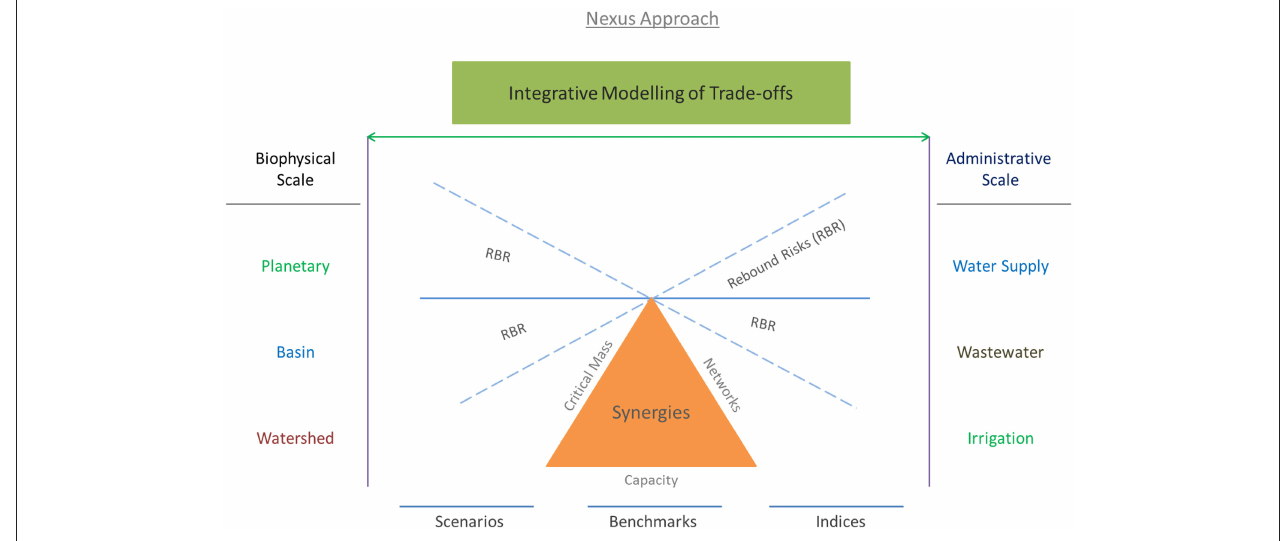
FIGURE 1 | Managing rebound effects in the water- energy-food nexus. Adapted from Kurian and Ardakanian (2015), Kurian (2017), and Kurian